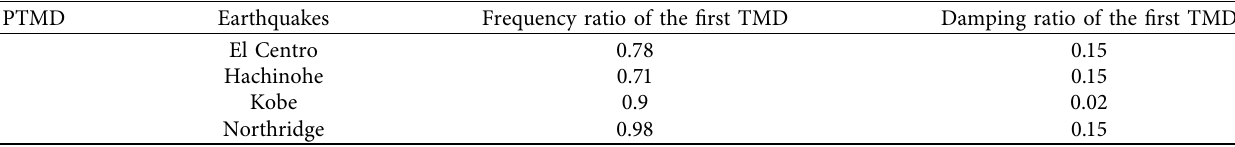
Table 2: Damping ratio and frequency ratio of PTMD.